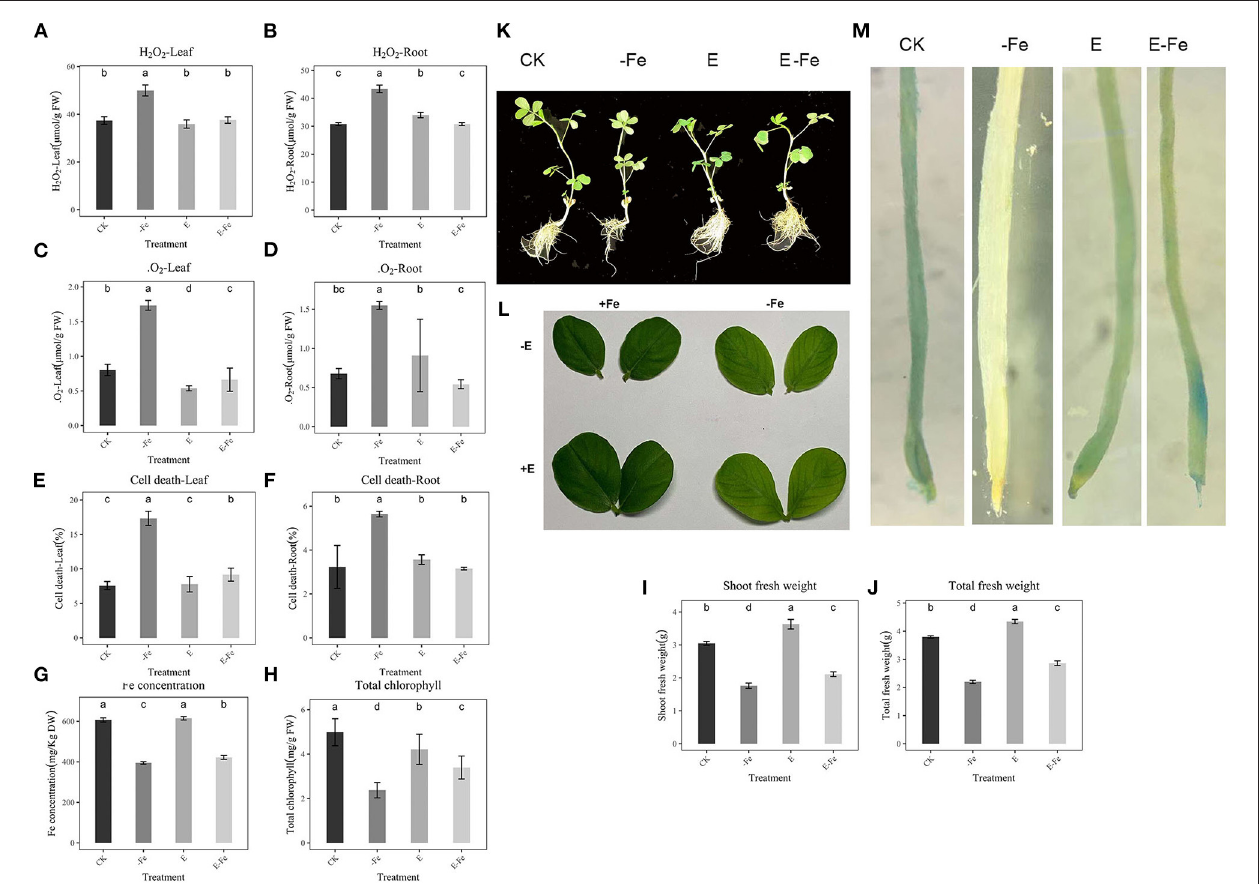
FIGURE 2 | Effect of P. liquidambaris and Fe-deficiency on peanut stress indicators. (A) : Effect of P. liquidambaris and Fe-deficiency on peanut H 2 O 2 content in leaf. (B) : Effect of P. liquidambaris and Fe-deficiency on peanut H 2 O 2 content in root. (C) : Effect of P. liquidambaris and Fe-deficiency on peanut · O 2 − content in leaf. (D) : Effect of P. liquidambaris and Fe-deficiency on peanut · O 2 − content in root. (E) : Effect of P. liquidambaris and Fe-deficiency on peanut cell death in leaf. (F) : Effect of P. liquidambaris and Fe-deficiency on peanut cell death in root. (G) : Effect of P. liquidambaris and Fe-deficiency on peanut Fe concentration. (H) : Effect of P. liquidambaris and Fe-deficiency on peanut chlorophyll content. (I) : Effect of P. liquidambaris and Fe-deficiency on peanut shoot fresh weight. (J) : Effect of P. liquidambaris and Fe-deficiency on peanut total fresh weight. (K) : Effect of P. liquidambaris and Fe-deficiency on peanut phenotype. (L) : Effect of P. liquidambaris and Fe-deficiency on peanut leaf. (M) : Effect of P. liquidambaris and Fe-deficiency on peanut Fe staining in root. Data and errors are mean ± SD, n = 6, and different letters indicate significant differences among treatments. p < 0.05. E = P. liquidambaris inoculation. -Fe = 2 µ mol FeEDTA in Hogland nutrition. CK = 100 µ